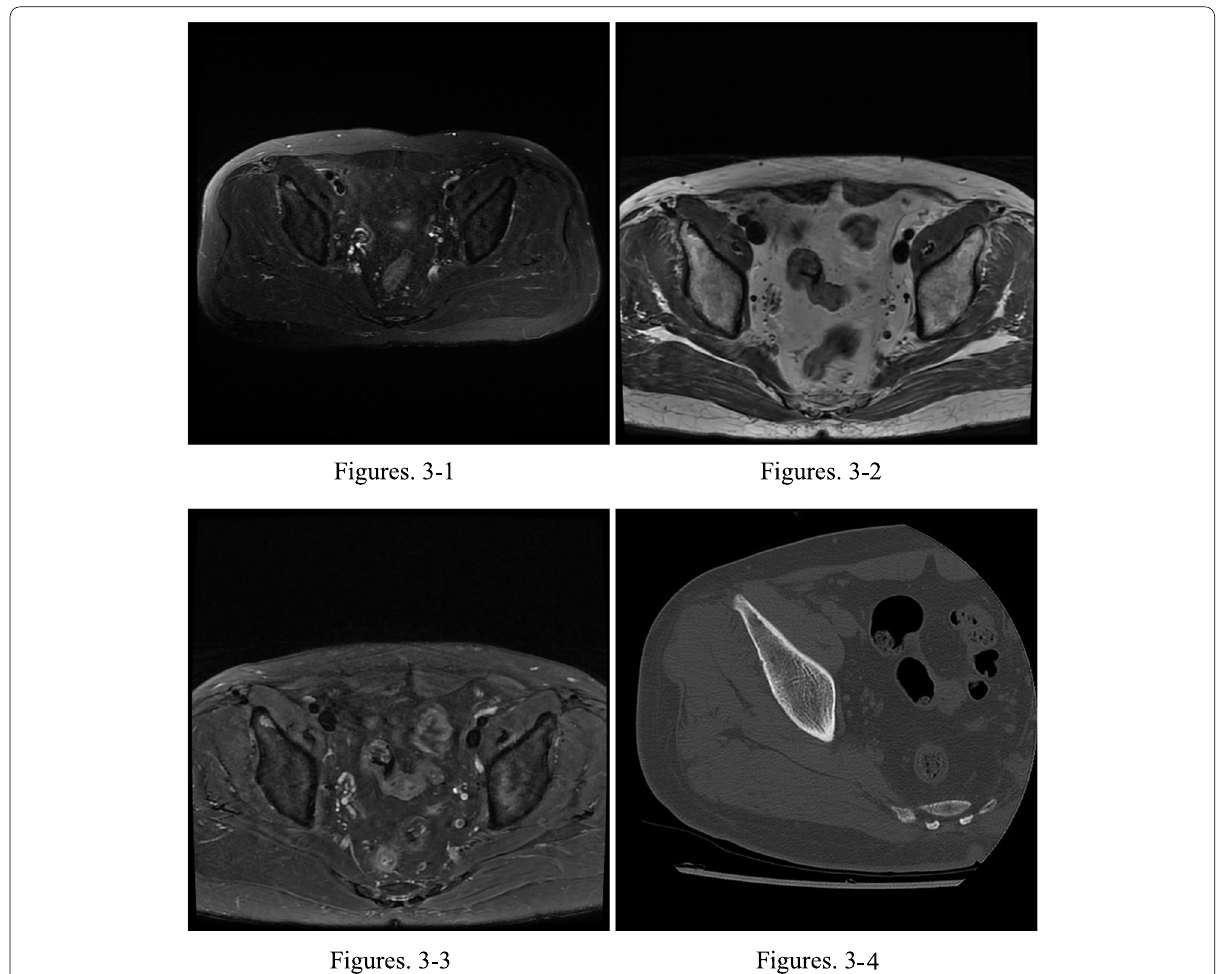
Fig. 2 2-1 T2WI pressure-fat in 2019, right iliac bone abnormal signal (arrow). 2-2 and 2-3 2020 T1WI, T2WI pressure-fat with increased iliac bone abnormal signal range. 2-4 2020 normal